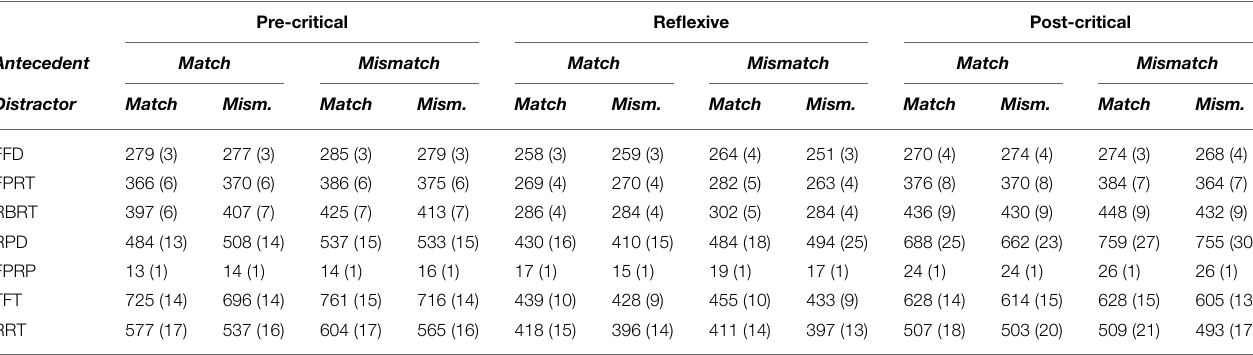
TABLE 3 | Experiment 1: Means and standard errors of raw first-fixation duration, first-pass reading time, right-bounded reading time, regression-path duration, total fixation time, re-reading time in ms, and first-pass regression probability in percentages at the pre-critical region, the reflexive and the post-critical region.